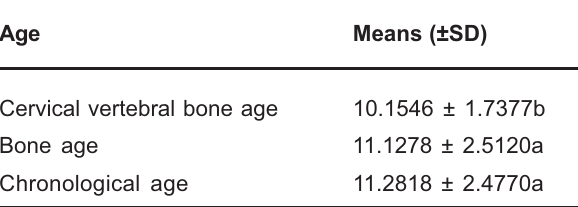
Different letters indicate statistically significant difference at 5% (Tukey’s